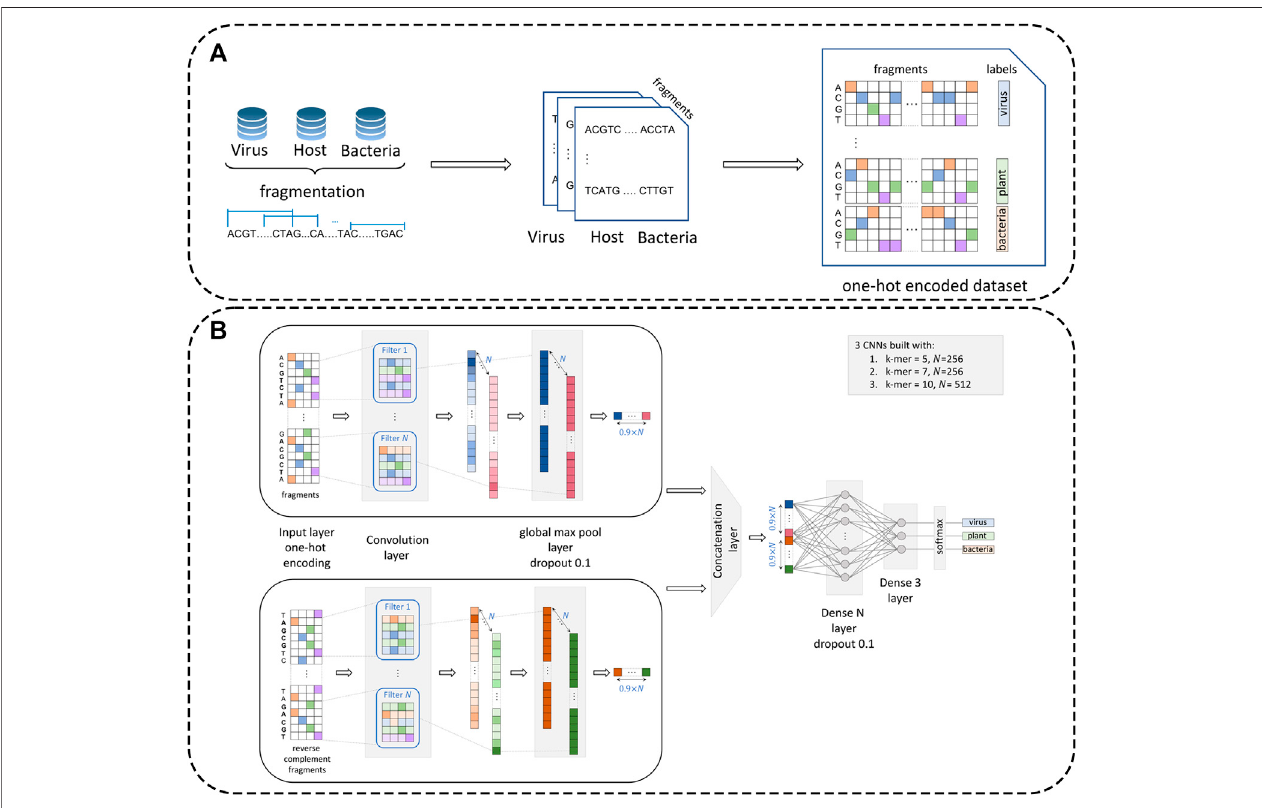
FIGURE 1 | Dataset preprocessing procedure and architecture of the multi-CNN module. Panel (A) : Reference datasets (virus, plant, and bacteria) are fi rst fragmentedwithapre-de fi nedfragmentsize(500and1000bp).Eachfragmentisfurtherone-hotencodedandcarriestheclasslabel.Panel (B) :ThreeCNNmodulesare built for k-mers of size k (cid:2) 5 , 7, and 10. One-hot encoded genomic fragments of a fi xed size are processed by convolutional and global max-pooling layers before being concatenated. A total of two dense layers are followed by the softmax activation function to produce a 3-class classi fi